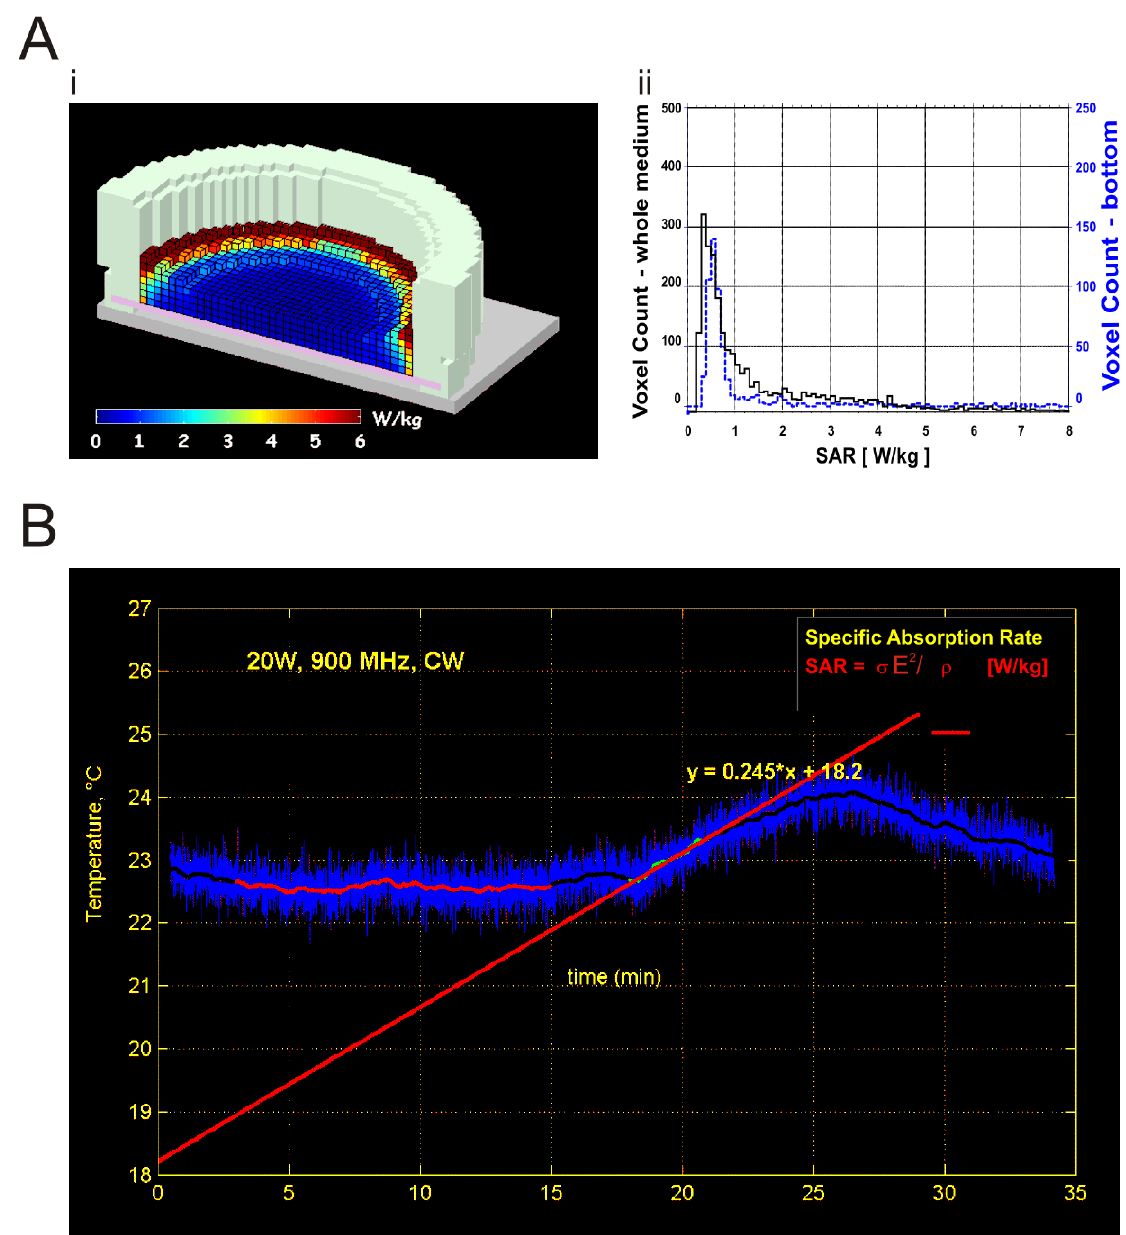
Figure 2. Computational and Experimental Estimates of the SAR Distribution in the Imaging Chamber. Ai ; the imaging chamber consisted of a 22 mm borosilicate coverslide (with adherent cells) sandwiched between a bevelled Teflon cylinder and retaining ring. The imaging chamber held a volume of 0.5 ml of HBSS. The finite-difference time domain (FDTD) method was used to compute the SAR distribution in the imaging chamber. A pseudocolored image of the distribution shows the homogeneity of SAR across the media, with the exception of gradients at the meniscus. Aii ; A histogram of the SAR distribution is shown for both the whole media (black solid line) and at the bottom of the media near the location of adherent cells (blue dotted line). B ; The SAR in the media per Watt of input power was determined experimentally by measuring the temperature change in the sample with a fluoroptic temperature probe when exposed to an incident continuous power of 20 W. The SAR was derived from the change in temperature ( D T u ) produced over time ( D t), given the specific heat capacity ( C ) of the sample, following SAR= C D T u / D t [W/kg]. The resulting SAR of the exposure configuration was estimated as 0.85 W/kg per W of incident power.